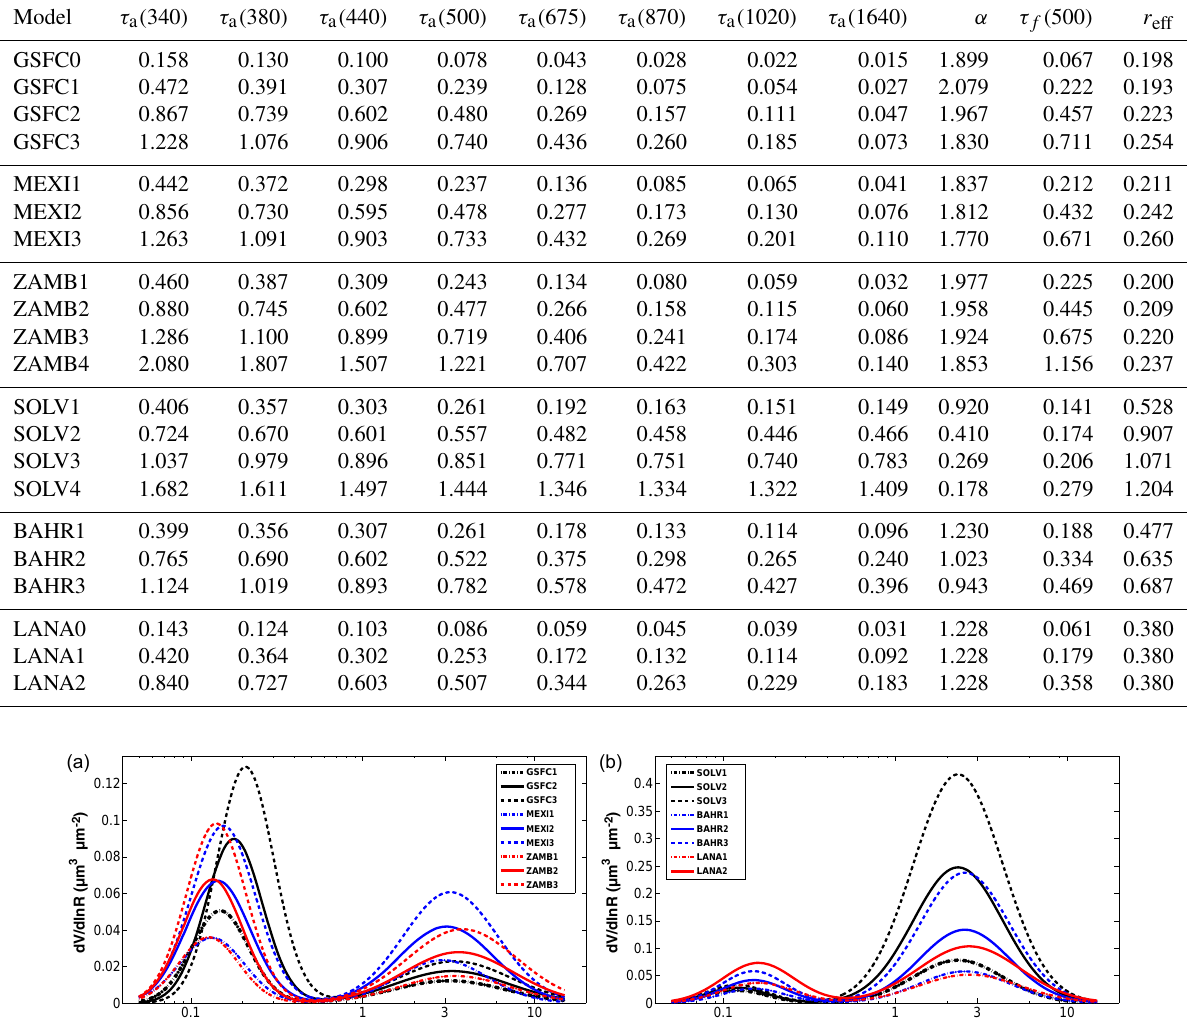
Table 2. Simulated aerosol optical depth values obtained from the aerosol examples described in Table 1. The Ångström exponent (rep- resented as α in the table) calculated from the 440, 675 and 870nm wavelengths is also depicted for each aerosol example. The last two columns include the values of the fine-mode aerosol optical depth at 500nm and the effective radius.